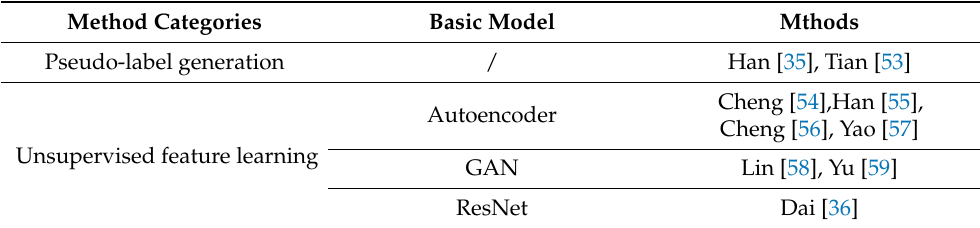
Table 1. Existing semi-supervised scene classification